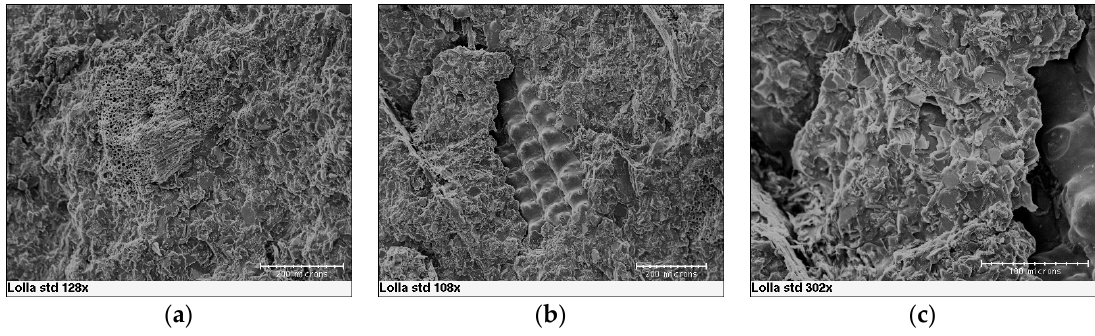
Figure 8. ( a – c ) SEM micrographs showing the interaction of rice husk within the poly(methyl methacrylate) matrix- alumina trihydrate (PMMA-ATH) matrix.